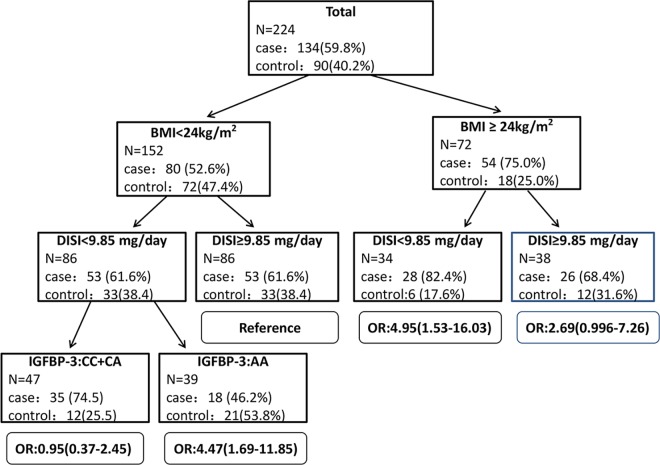
CART analysis of IGF-1 and IGFBP-3 genetic polymorphisms and environmental factors among postmenopausal women.This figure summarizes the results of CART analysis for postmenopausal women. The risk for subgroups was also evaluated using ULR with adjustment for education, income, age at first pregnancy, parity, breast feeding, and estrogen use. The results of ULR, ORs, and their 95% confidence intervals for each subgroup are shown by the side of each terminal node of the tree.